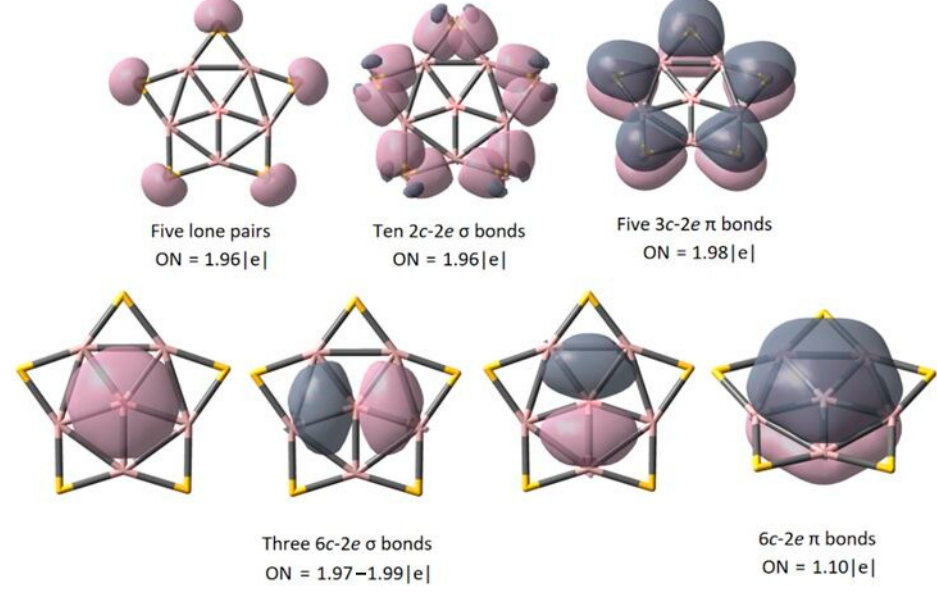
Figure 4. AdNDP analysis of D 5h BAl 5 S 5+ .